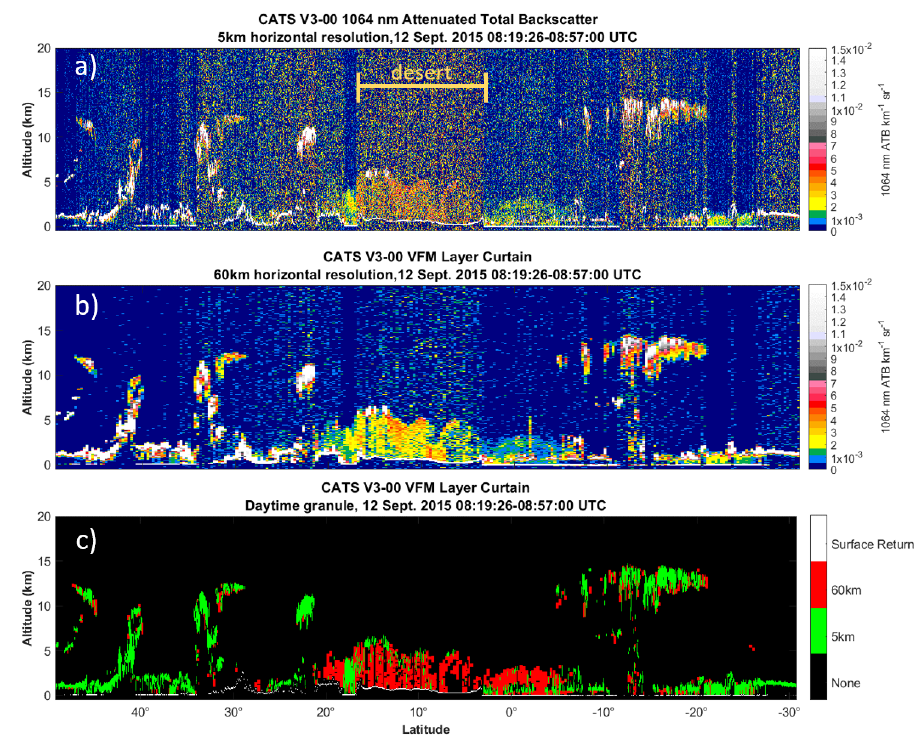
Figure 3. The CATS 1064 nm attenuated total backscatter (ATB) averaged horizontally to 5 km ( a ) and 60 km ( b ), as well as the layers reported in the V3-00 data products ( c ) detected at both 5 km (green) and 60 km (red) for a case on 12 September 2015 over bright deserts of the Middle